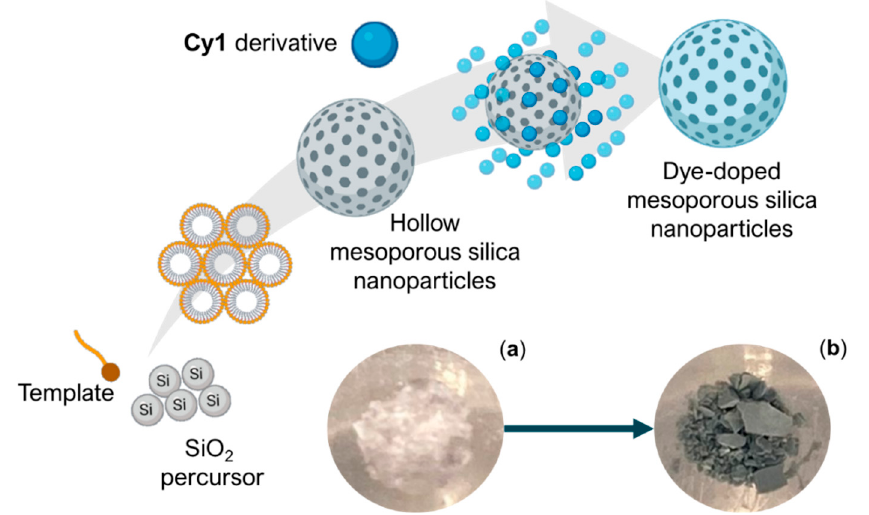
Figure 3. Schematic overview of the synthesis process of Cy1 -doped mesoporous silica nanoparticles. Colourimetric alterations of mesoporous silica nanoparticles before ( a ) and after ( b ) Cy1 derivative incorporation.